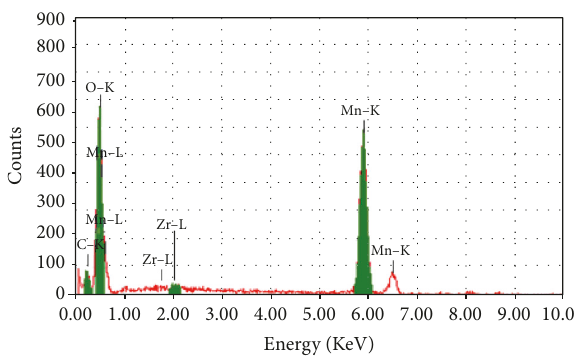
Figure4:TheHRTEMimagesof1%ZrO